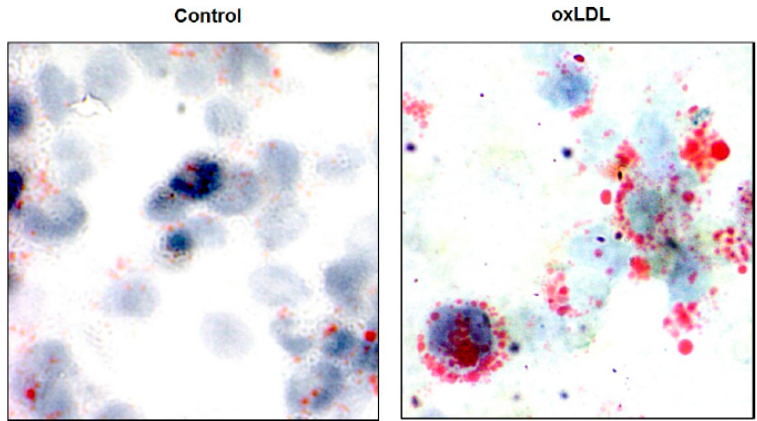
Figure 1. Foam cell formation. Foam cells were formed after the incubation of human monocyte derived from macrophages with 100 μ g/mL of oxidized low-density lipoprotein (LDL) for 2 days. After fixation with formalin for 1 h, intracellular lipids were stained using Oil Red O. Images were prepared with an Olympus microphotographic system at a magnification of 60×.